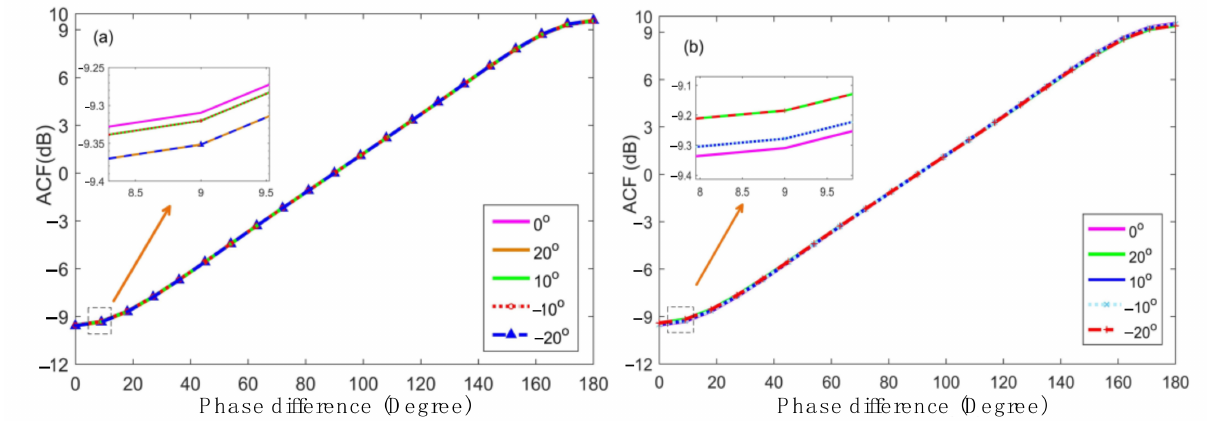
− 20 ◦ , − 10 ◦ , 0 ◦ , 10 ◦ 3 deviation of